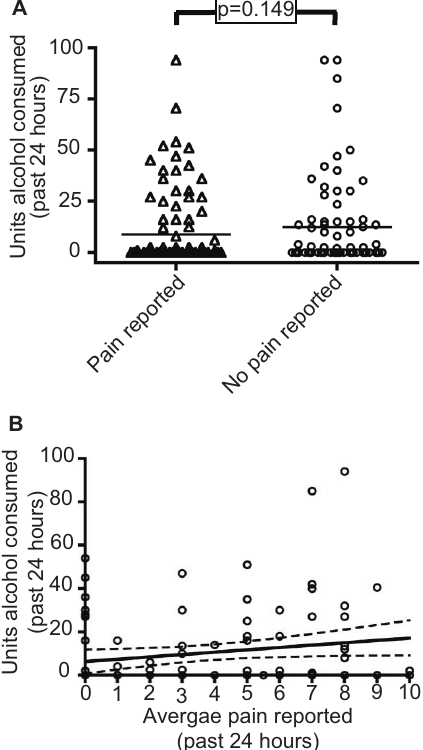
Figure 3. Pain intensity reported by homeless people categorised by alcohol use. A ) S catter plot showing the amount of alcohol consumed by homeless people reporting versus those who did not. Bars indicate means. B ) Linear regression plot showing lack of relationship between quantity of alcohol consumed and intensity of pain reported. The unbroken line represents the best-fit slope and the broken lines the 95% confidence intervals (best-fit slope 0.579, 95% CI -0.06–2.24, r 2